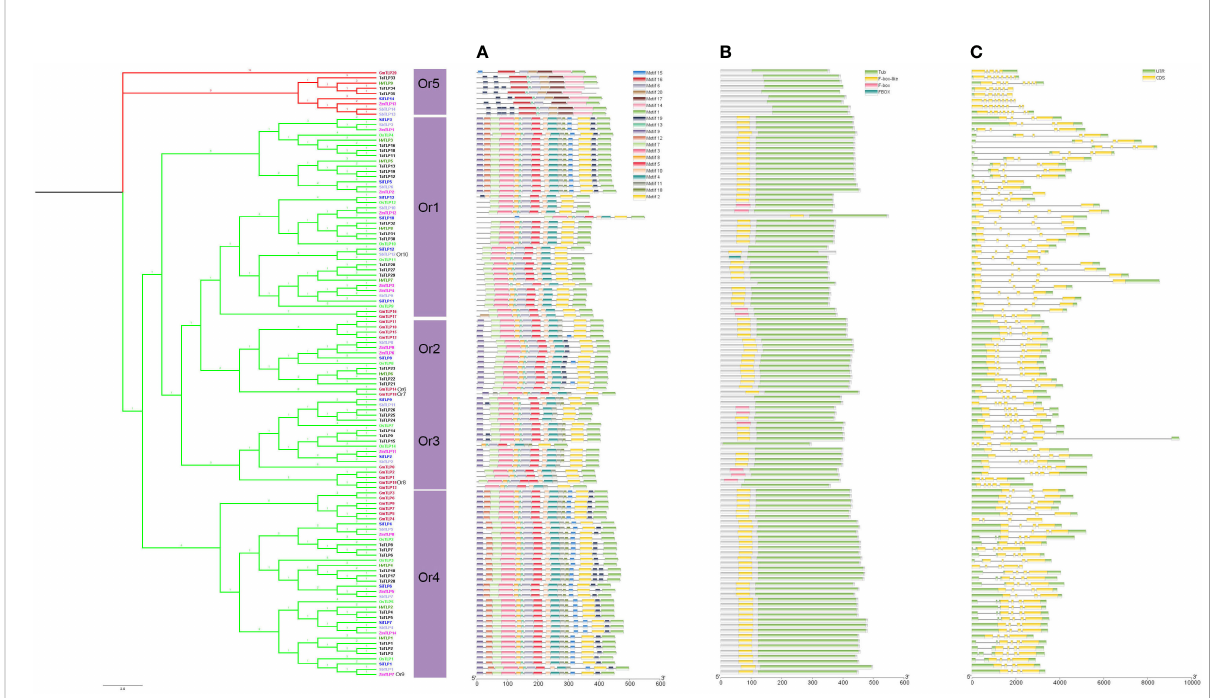
FIGURE 5 The phylogenetic tree, conserved motif, domain, exon/intron structure compositions of the TLP genes in seven species. Phylogeny tree of TLP proteins from seven species. Different colors of branches represented different groups. The different species were showed by different colors.